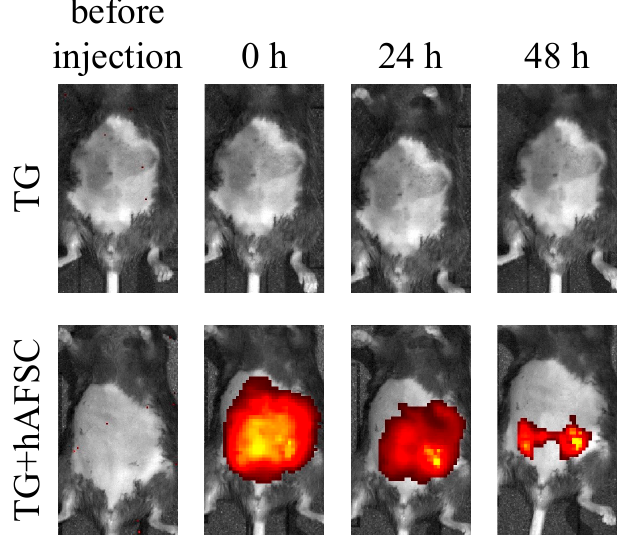
Figure 3. Distribution of DiR-labelled hAFSCs after intraperitoneal implantation. Distribution of hAFSCs ( n = 5) after injection was determined using in vivo imaging (IVIS ® ). Images display the ventral side and reveal the aggregation of transplanted cells over time.